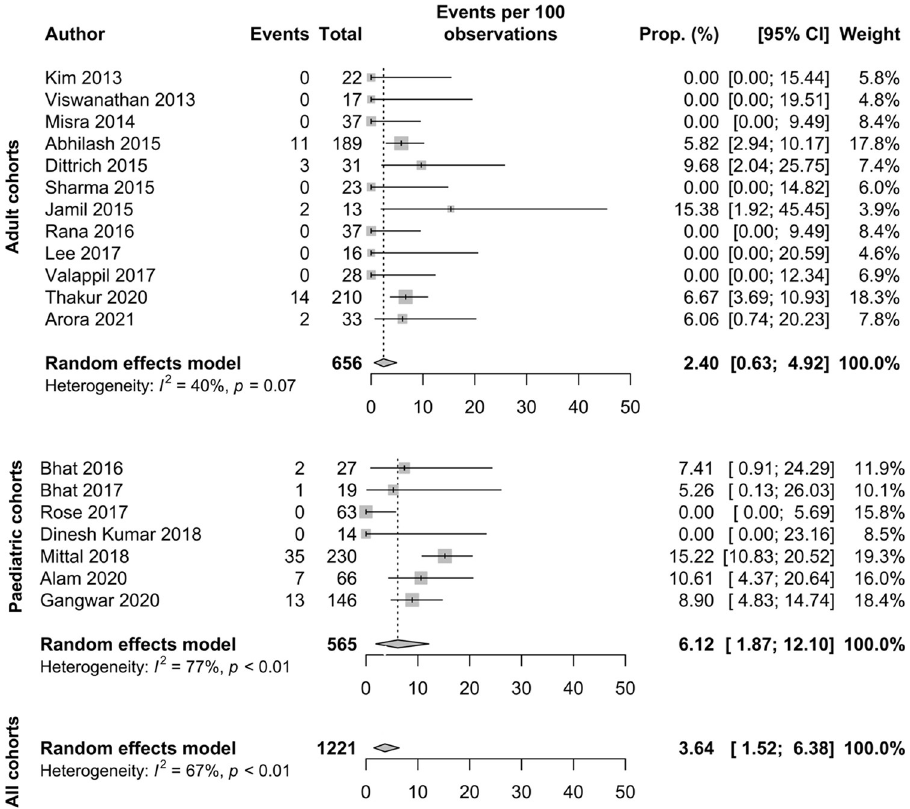
Fig 3. Forest plot showing case fatality ratio for adult, paediatric and combined cohorts; events are defined as number of in hospital fatalities [8,11–17,19–22,24–26,28,29,37].